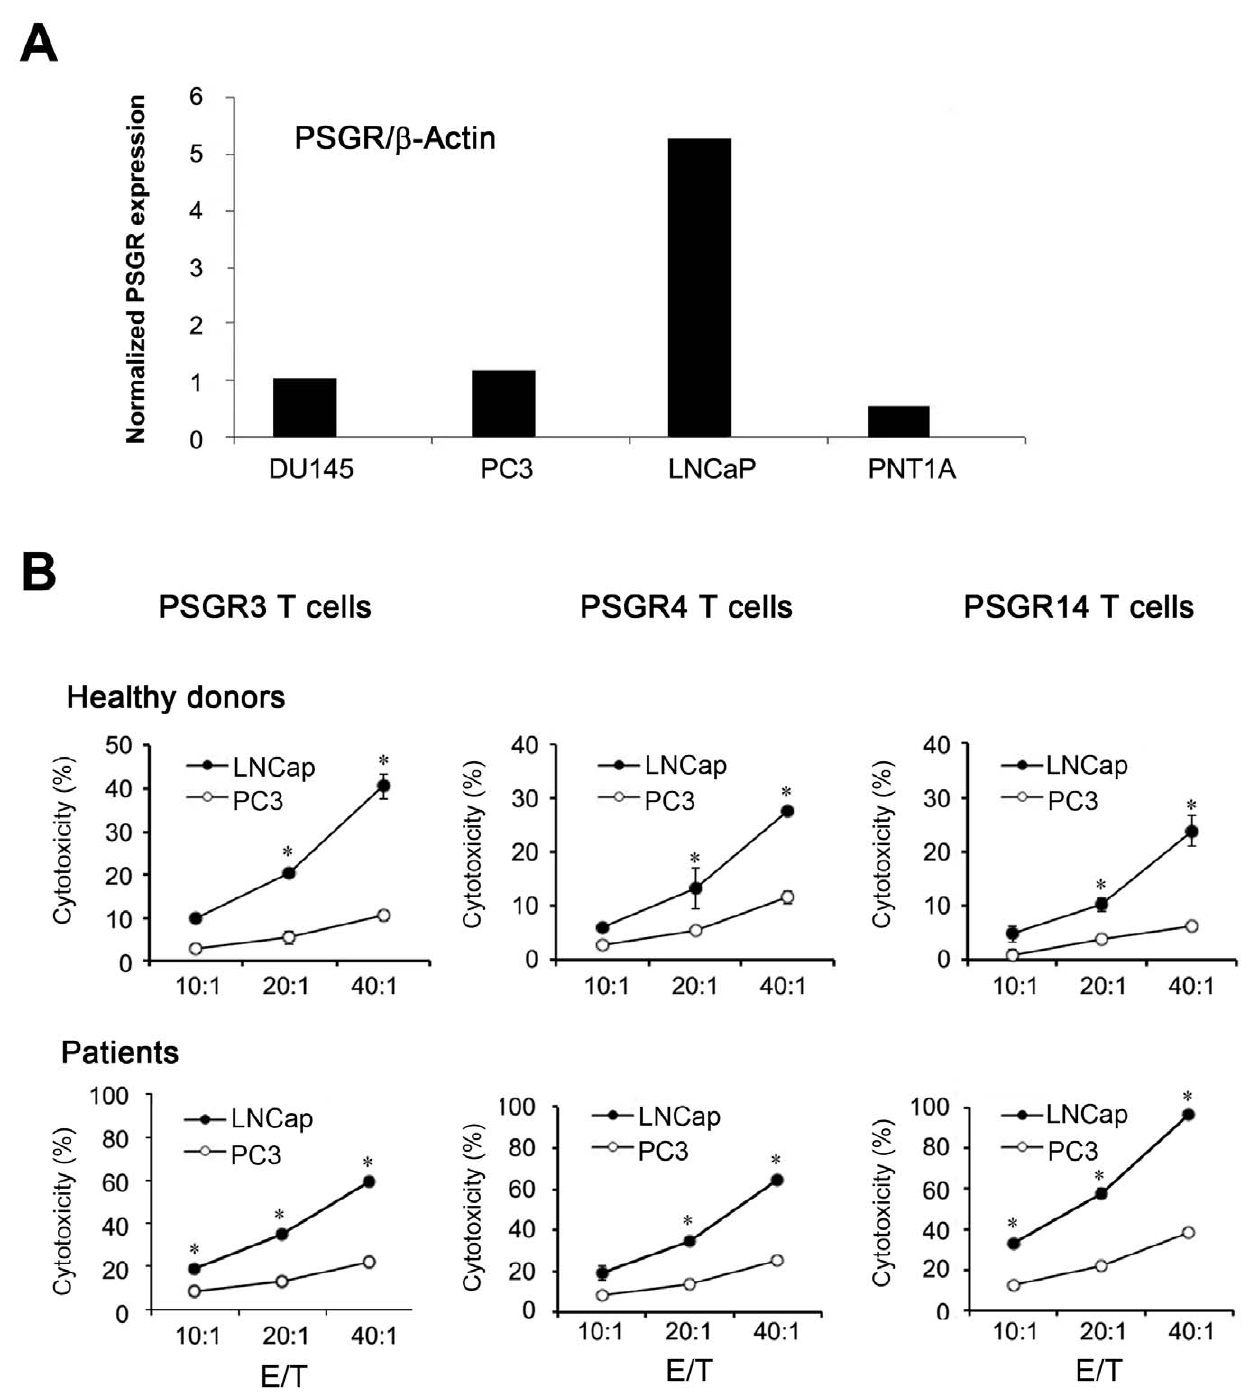
Figure 2. PSGR-derived peptide-specific T cells recognized HLA-A2 positive PSGR-expressing LNCaP prostate cancer cells. The expression of PSGR mRNA in different cell lines was determined by RT-PCR (A). PSGR derived peptide-specific T cells were tested for cytotoxicity against both PC3 and LNCaP by the LDH assay (B). Data from B are plotted as means 6 SD. Results are representative of three independent experiments. * P , 0.05, versus control.